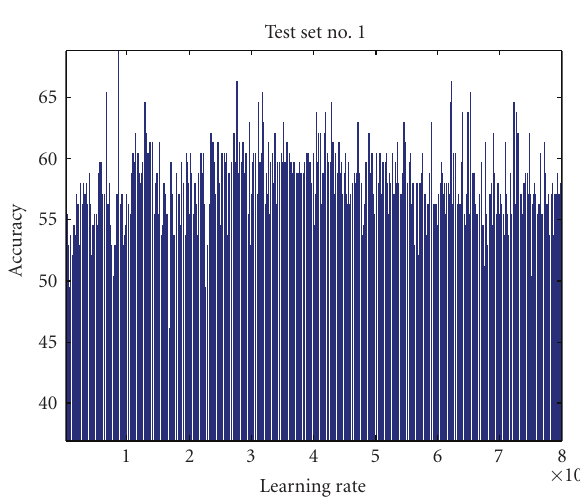
Figure 4: Learning rate impact on accuracy for test set number 1 (all other parameters were kept